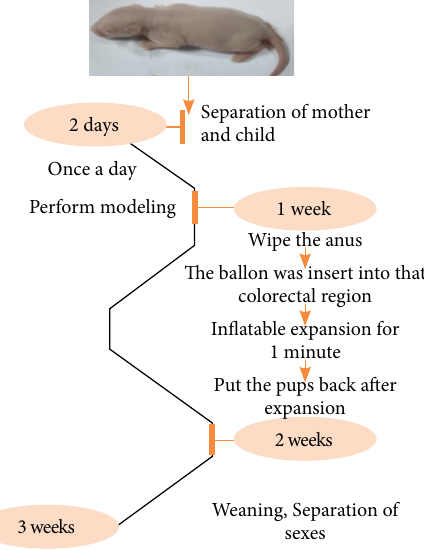
Figure 1 - Flow chart of rat model of irritable bowel syndrome-like functional chronic visceral pain. Model exclusion criteria 14 : (1) Rats with too much or too little weight in each cage; (2) Rats which died before